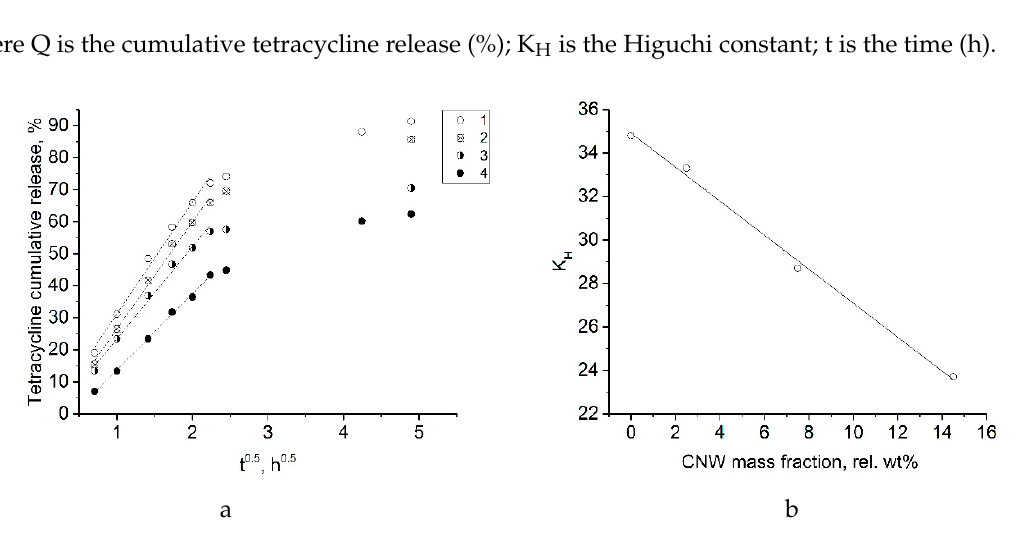
Figure 10. ( a ) Linearized tetracycline release curves plotted as a cumulative release vs. square root of time for ALG-CNW hydrogels: 1—ALG, 2—ALG-CNW (2.5%), 3—ALG-CNW (7.5%), 4—ALG-CNW (14.5%); ( b ) K H from the Higuchi model for 0–5 h release vs. CNW content.